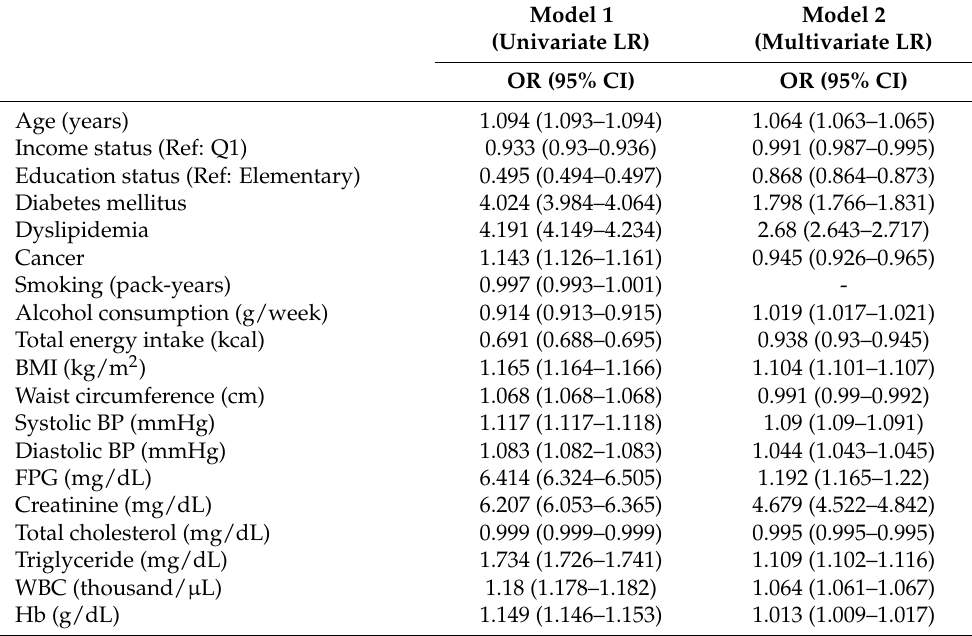
Table 3. Risk factors for hypertension selected by backward-stepwise logistic regression in Korean